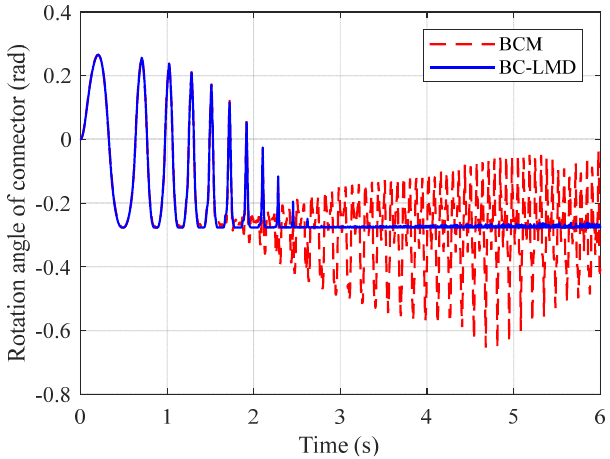
Figure 7. Lower bound of the rotation angle of the connector.